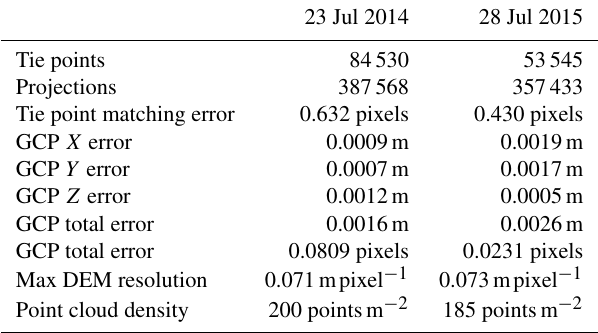
Table 4. Estimated pixel matching and DEM reconstruction errors from SfM processing